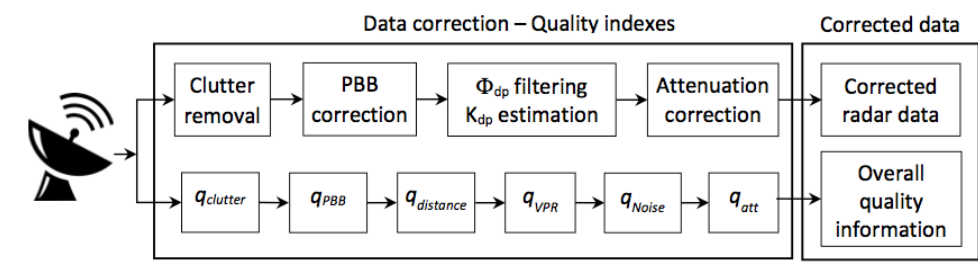
Figure 3. Weather radar data processing chain.